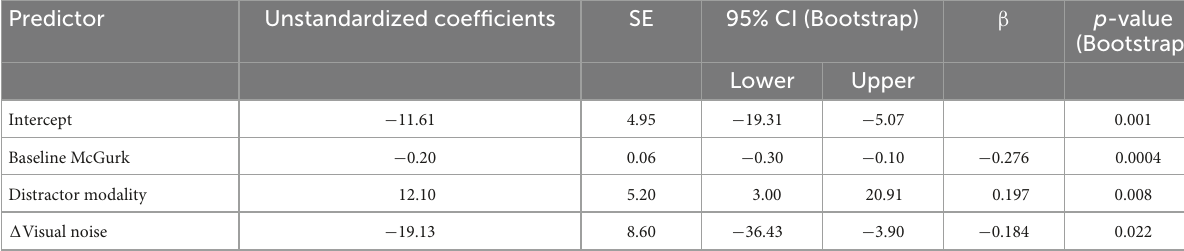
TABLE 2 Multiple linear regression: Dual-task McGurk reports showing predictive power of distractor modality, baseline McGurk, and (cid:49) visual noise on (cid:49) McGurk responses from NL to HL.